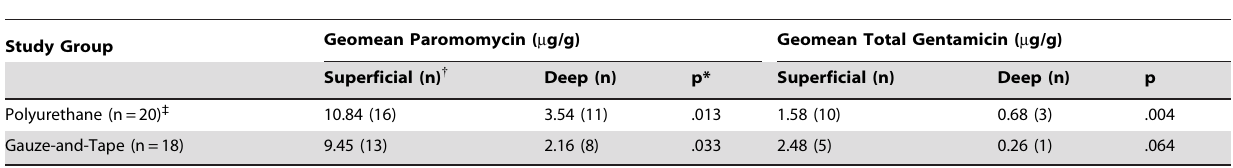
Table 5. Geometric mean aminoglycoside concentrations in superficial and deep dermis.